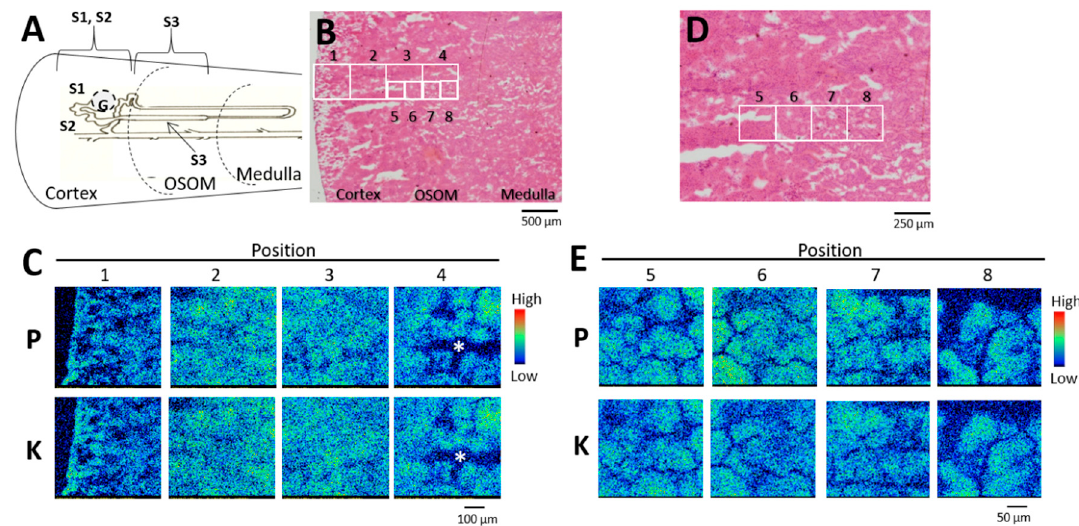
Figure 1. Phosphorus and potassium distribution in control kidney. ( A ) Nephron unit distribution. G, glomeruli; S1, S2, and S3, segments of proximal tubule. ( B , D ) Serial sections stained with hematoxylin and eosin. ( C ) Elemental imaging (scanned area, 500 μ m × 500 μ m; integrated current, 0.2 μ C; beam size, 1 μ m × 1 μ m) in boxed areas 1–4 in ( B ). ( E ) Elemental imaging (scanned area, 250 μ m × 250 μ m; integrated current, 0.2 μ C; beam size, 1 μ m × 1 μ m) in boxed areas 5–8 in ( D ). P, phosphorus; K, potassium. *Artificial crack. The periphery of the renal cortex is on the left side of all images.